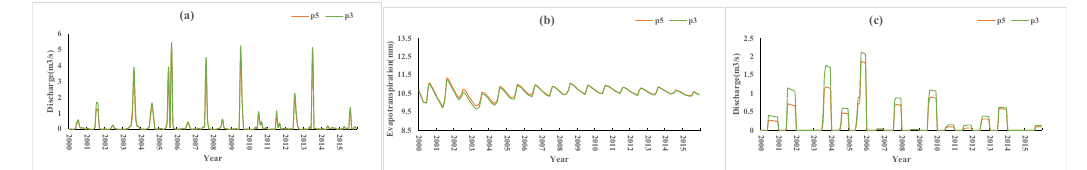
Figure 12. P5 vs. P3 simulation results: ( a ) surface runoff, ( b ) evapotranspiration, ( c ) farmland runoff.